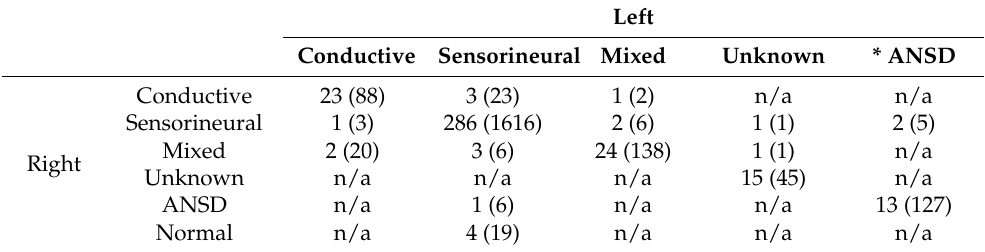
Table 2. Early Intervention (EI) group (FLI-P data points) by type of bilateral hearing loss. Left Conductive Sensorineural Mixed Unknown * ANSD